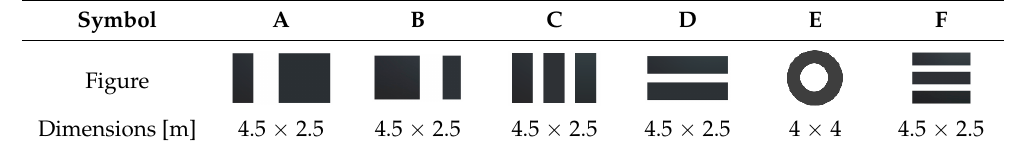
Table 2. Set of symbols presented to the user. Symbol